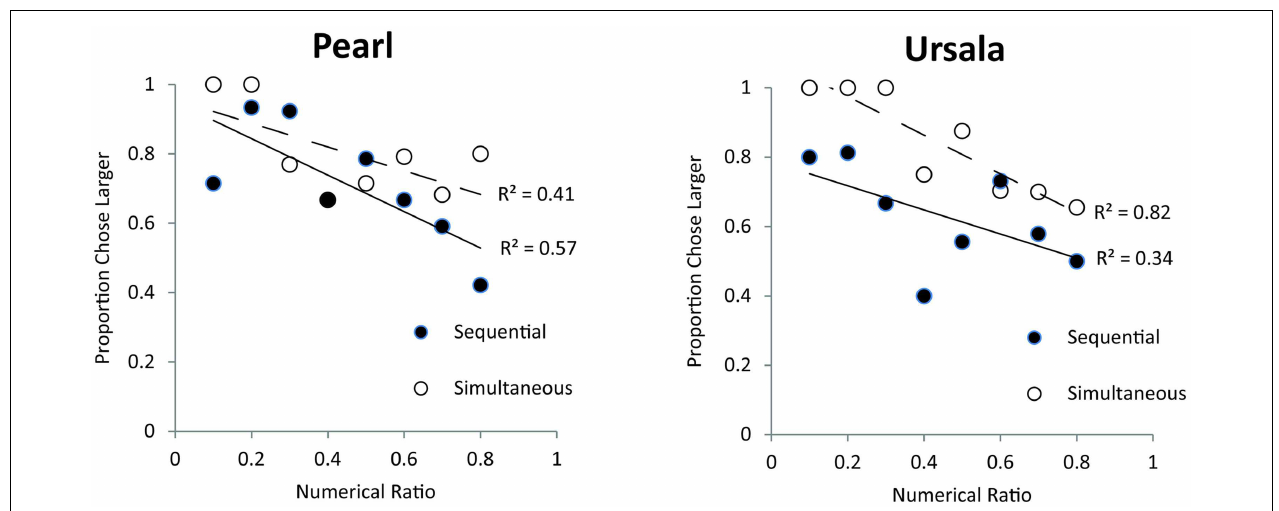
FIGURE 5 | Effect of numerical ratio on accuracy from the two monkeys (Pearl and Ursala) tested in the longer exposure (Experiment 2) for sequential (filled circles) and simultaneous trials (open circles) .Trend lines represent linear trends of decreasing accuracy with finer numerical ratios.